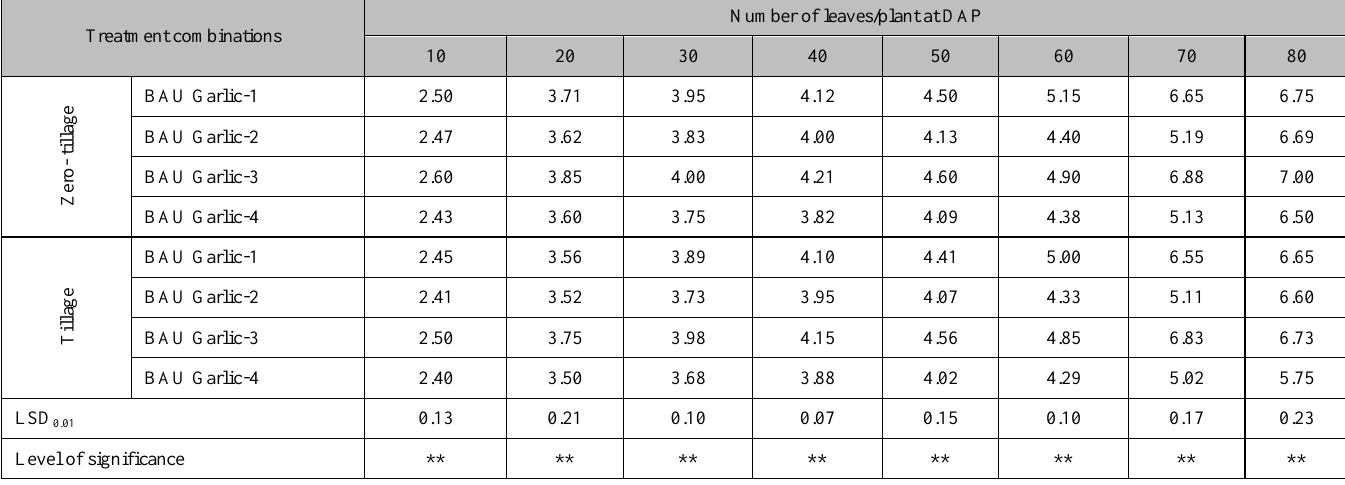
Table 2. Combined effects of planting system and variety on number of leaves of garlic at different days after planting (DAP). Treatment combinations